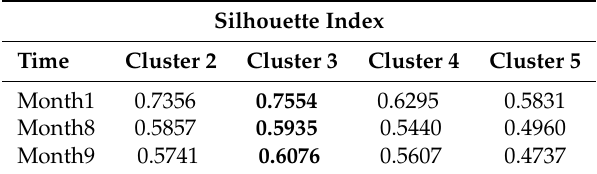
Table 2. Silhouette index test for cluster number